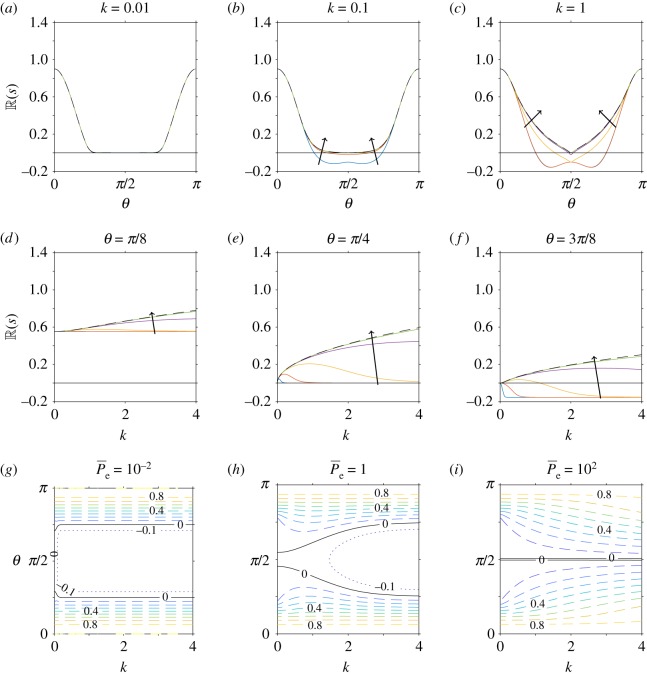
Linear stability analysis of a nearly aligned suspension, for variations in translational diffusivity (Péclet number) but neglecting anisotropic effects. In all plots, the volume fraction, shape parameter and stresslet strength are constant (ϕ = 0.2, α0 = 0.8 (equivalent to Γ = 3), α1 = − 1). (a–f) The real part of the growth rate (R(s)) for changing Péclet number P¯e=10−2, 10−1, 1, 101, 102, where the arrow indicates the direction of increase. The dependence of R(s) on the wave-direction θ is shown for fixed values of the wavenumber (a) k = 0.01, (b) k = 0.1, (c) k = 1, and the dependence of R(s) on k for fixed values of (d) θ = π/8, (e) θ = π/4, (f) θ = 3π/8. The dashed line corresponds to ϕ = 0 and 1/P¯e=0, i.e. the diffusion-free regime considered by Saintillan & Shelley [32]. (g–i) The dependence of R(s) on k and θ for fixed values of (g) P¯e=10−2, (h) P¯e=1 and (i) P¯e=102. Here the spacing of contour lines represents a change of 0.1 to R(s). The black solid line in all plots indicates R(s)=0, i.e. the boundary between instability and stability.